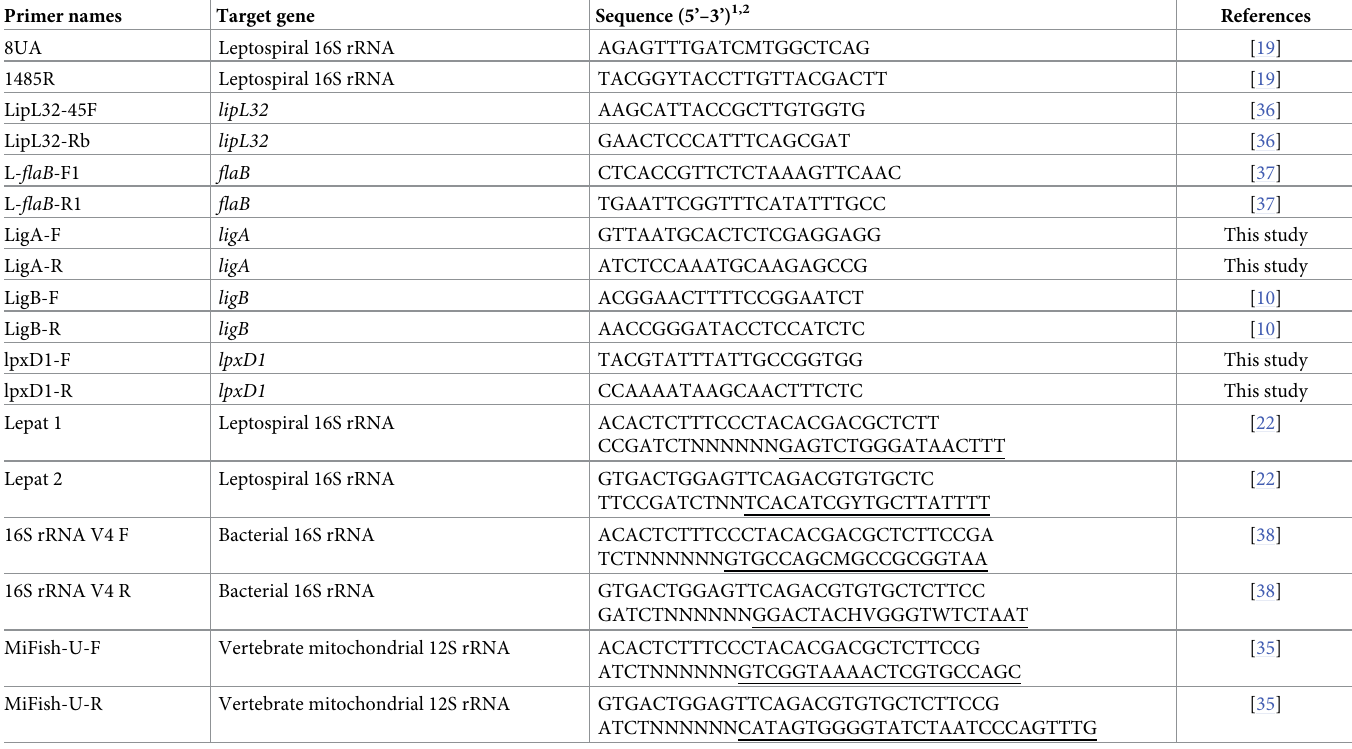
Table 1. List of primers used for PCR analysis or environmental DNA metabarcoding sequencing by Illumina MiSeq